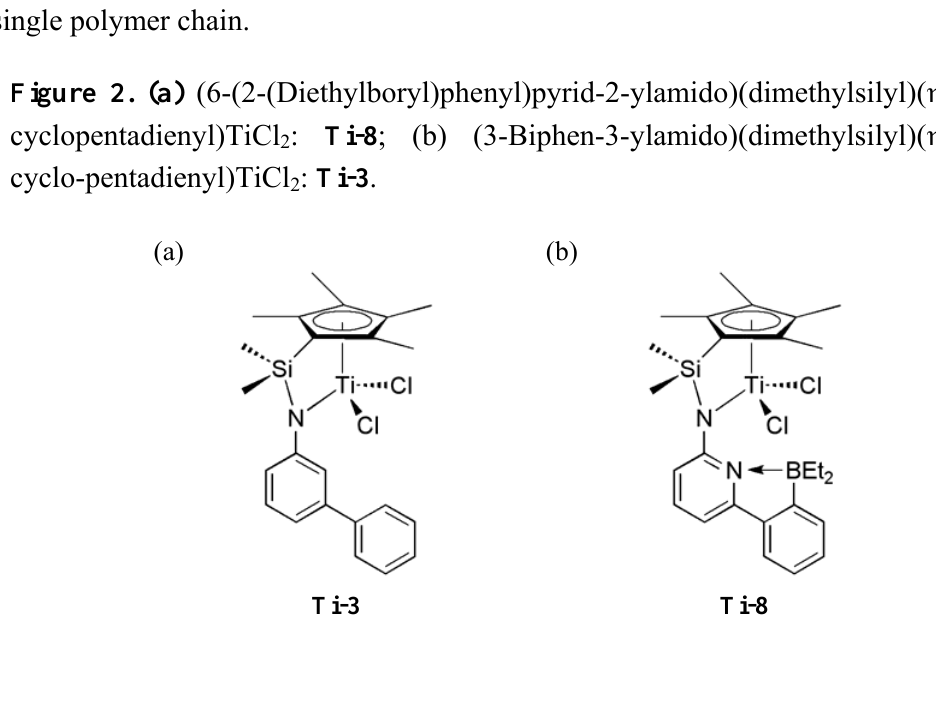
Figure 2. (a) (6-(2-(Diethylboryl)phenyl)pyrid-2-ylamido)(dimethylsilyl)(  5